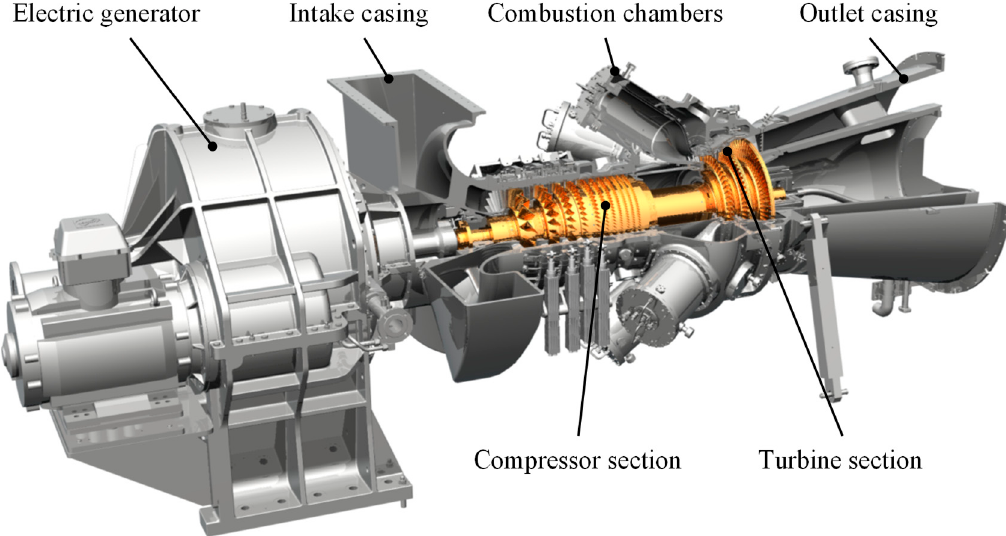
Figure 2 . Typical gas turbine construction. Figure 2. Typical gas turbine